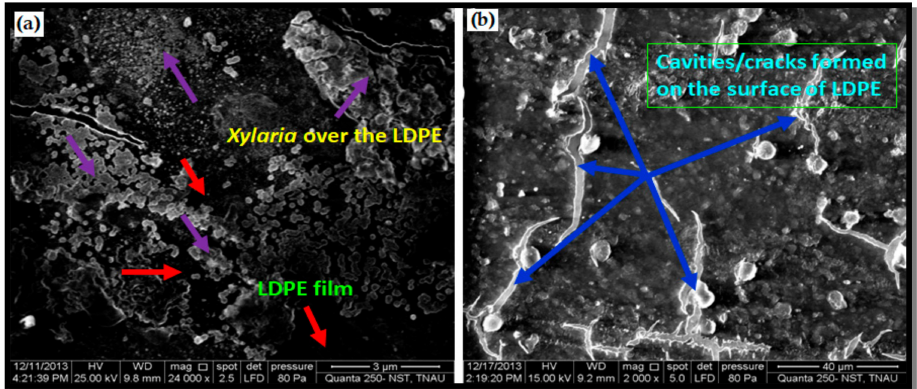
Figure 4. ( a ) SEM images of Xylaria over the LDPE, ( b ) cavities/cracks formed on the surface of LDPE. The LDPE surface is shown by the red color arrows. The Xylaria is depicted by the violet-colored arrows above the